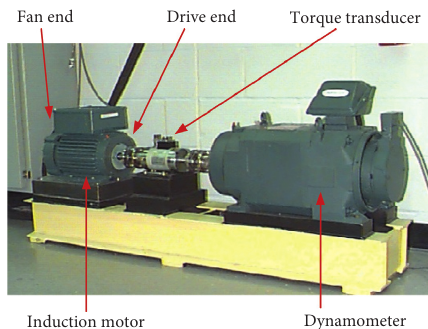
Figure 5: The experiment platform.